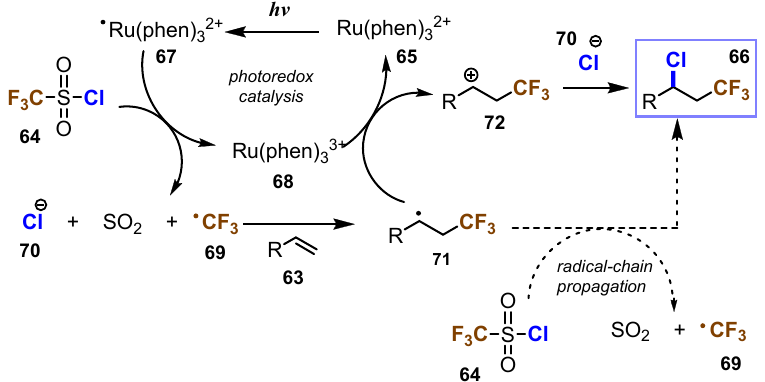
Scheme 18. Proposed mechanism of chlorotrifluoromethylation of